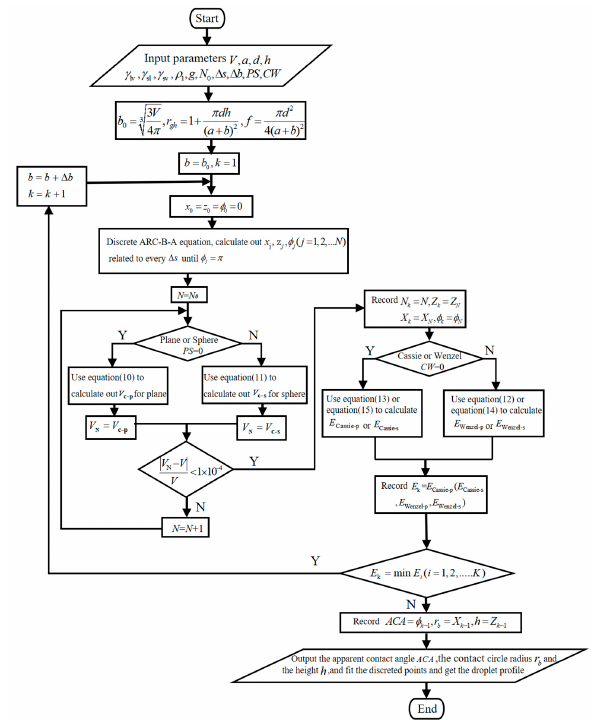
Figure 4. Flow chart of the calculation of the wettable parameters of the axisymmetric heavy droplet. Briefly, the process is as follows: set the initial value of the droplet size factor b as the droplet equivalent radius ; use the arc difference method to get the coordinates of 0 b every difference point on the profile; use volume constraint to define the position of the ; step forward b by b solid ‐ liquid interface ( v z ); calculate out the total energy with 0 b ; repeat the aforementioned process; calculate total energy until the calculated total energy begins to increase with b ; record the minimum energy state and corresponding ACA, b r and h. PS is a symbol of the shape of the solid ‐ liquid contact area and CW is the sym ‐ bol of the droplet wetting state.